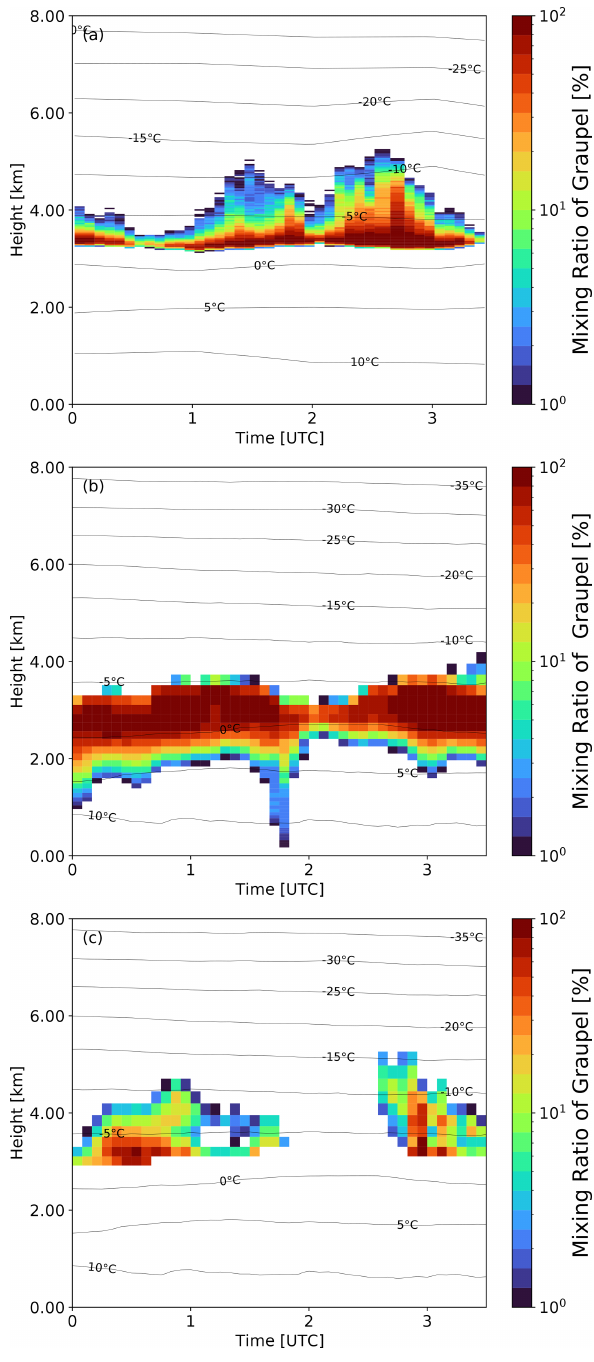
Figure 8. Retrieved and simulated graupel mixing ratios, defined as the percentage of graupel in the total hydrometeor mass, for the stratiform rain event shown in Fig. 7 (7 October 2014, 00:00– 03:30UTC). An advanced hydrometeor classification and quantifi- cation algorithm has been applied to polarimetric BoXPol measure- ment (a) and to simulated radar variables based on COSMO sim- ulations (c) and compared to the COSMO-simulated graupel mix- ing (b)